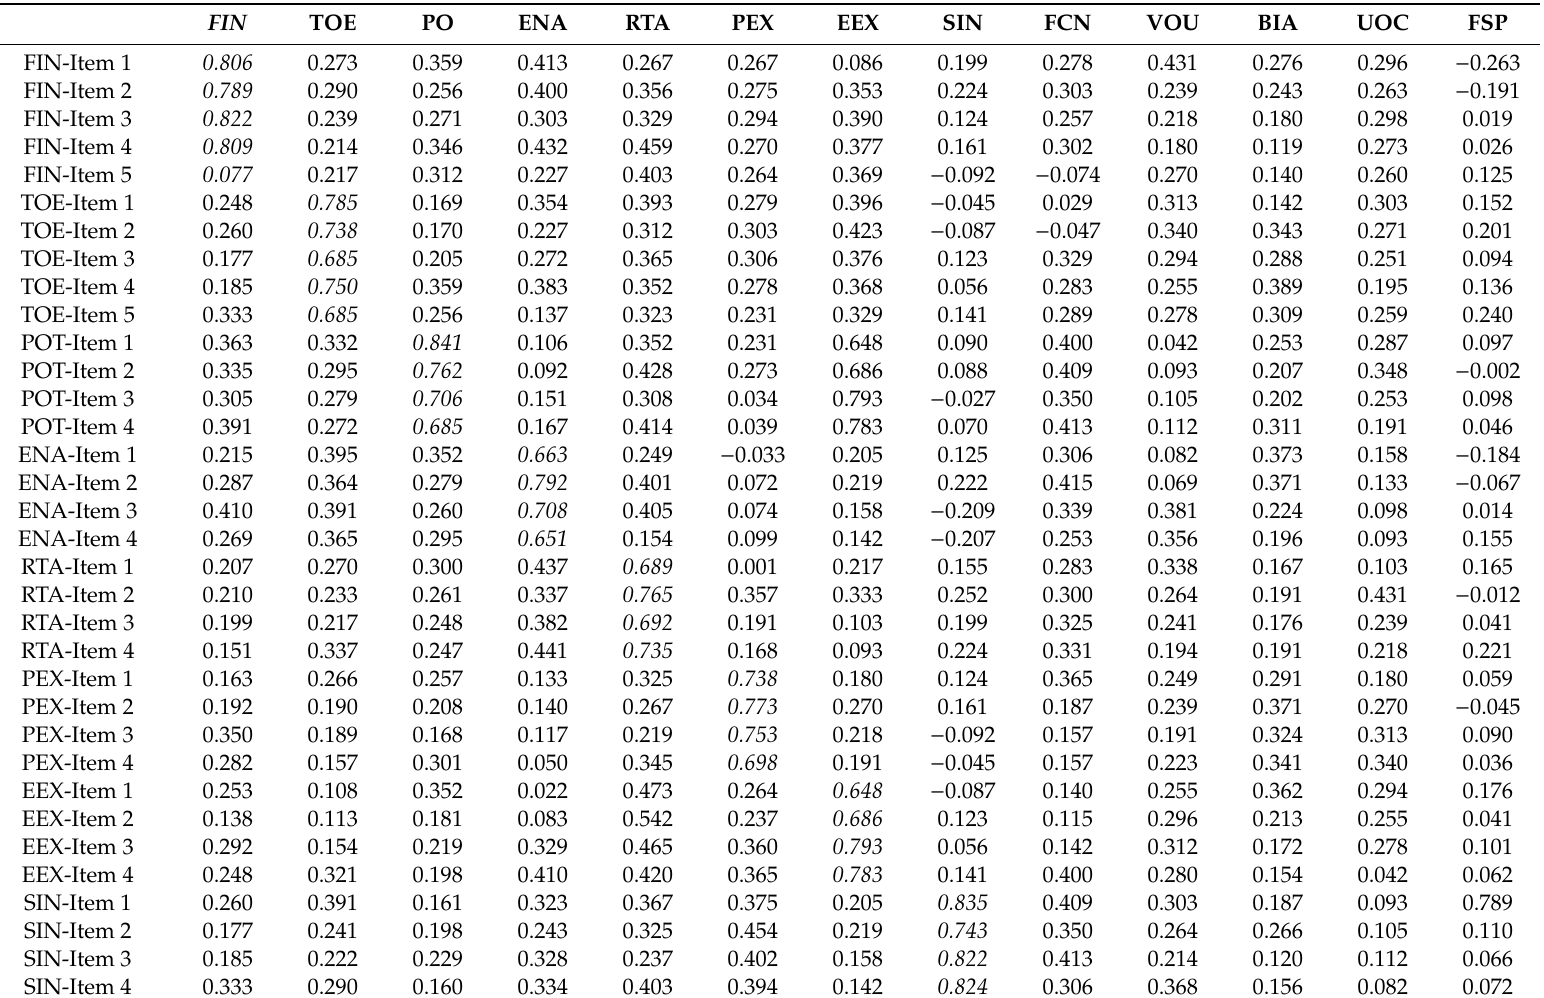
Table A1. Outer Loading and Cross